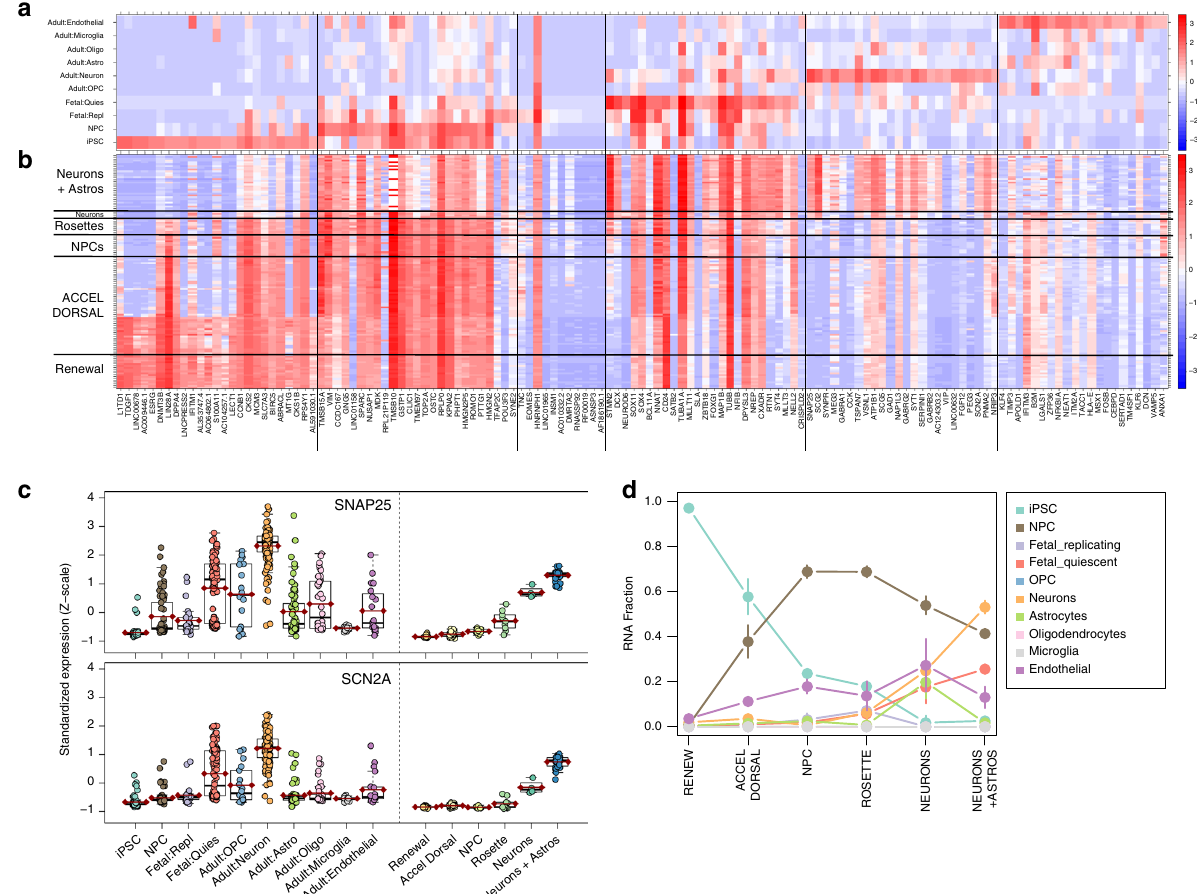
Fig. 5 Deconvoluting RNA from the underlying cell types across differentiation. a The mean standardized expression in the single-cell reference data of the 131 genes that were found to distinguish iPSCs (25 genes), NPCs (25 genes), fetal replicating neurons (11 genes), fetal quiescent neurons (25 genes), adult neurons (24 genes), and adult endothelial cells (21 genes). b The mean standardized expression of our time-course data across these 131 genes, showing expected higher expression of iPSC genes in the earlier time-course samples, and higher adult neuronal genes in the samples of neurons on astrocytes. c Boxplots of the standardized expression in both the single-cell reference data and time-course data of two genes, SNAP25 and SCN2A , that distinguish adult neurons. d The RNA fraction of cell types of our bulk data estimated by the deconvolution algorithm, showing the fall of iPSCs and the rise of fetal quiescent and adult